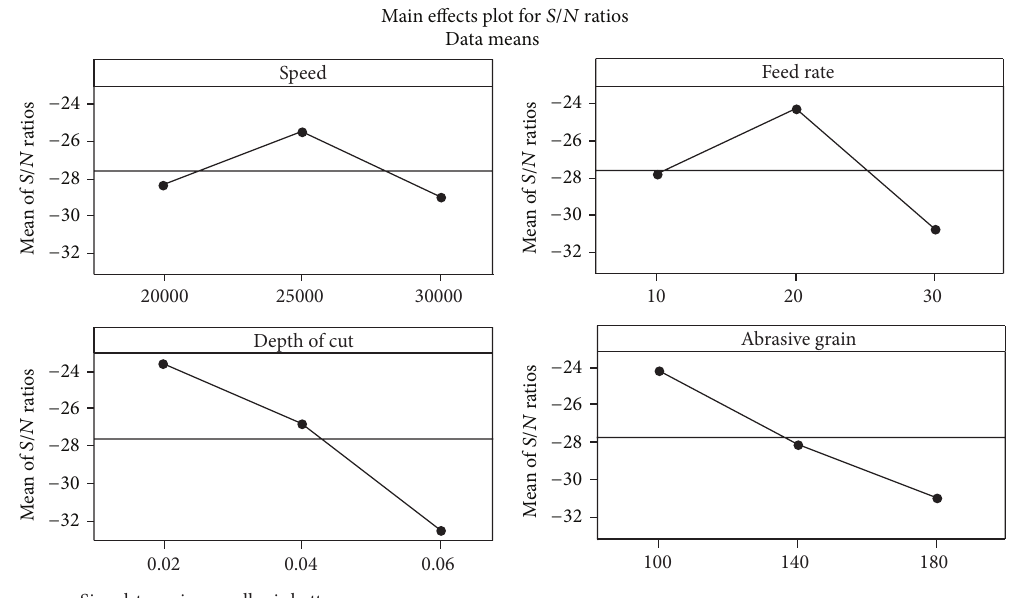
Figure 4: Response diagram for cracking percentage.